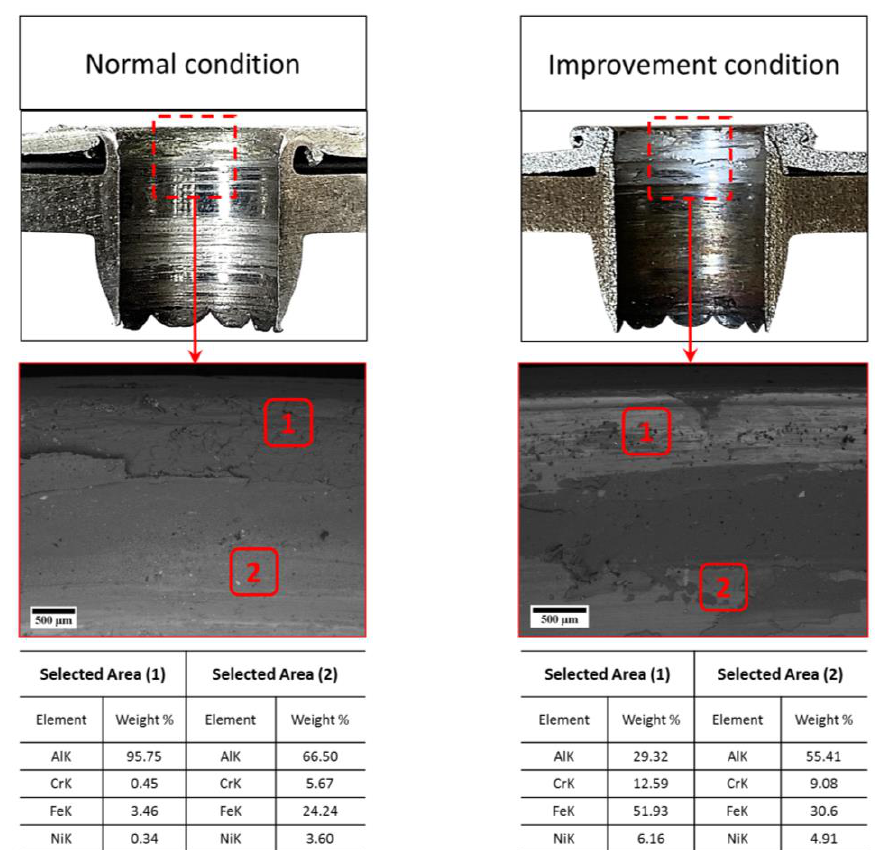
Figure 16. Cross-section and close-up views, and energy-dispersive X-ray analysis of edge zones for friction drilled joints, under normal and improvement conditions.